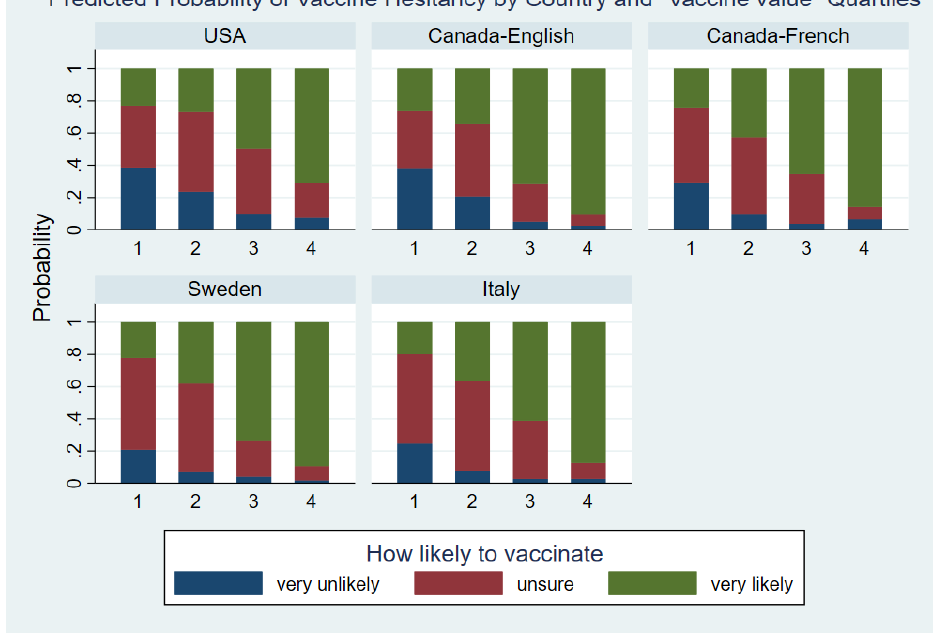
Figure 3. Predicted Probability of Vaccine Hesitancy by Country and “Vaccine value” Quartiles .